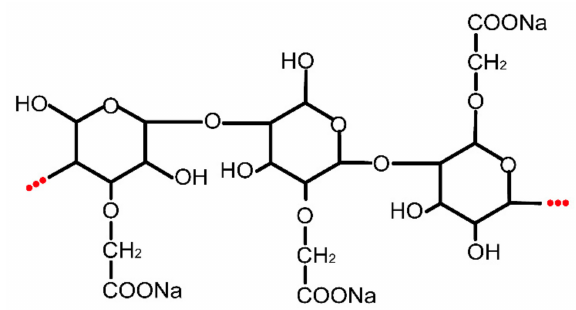
Figure 14. Chemical structure of CMS used as a viscosity modifying agent in